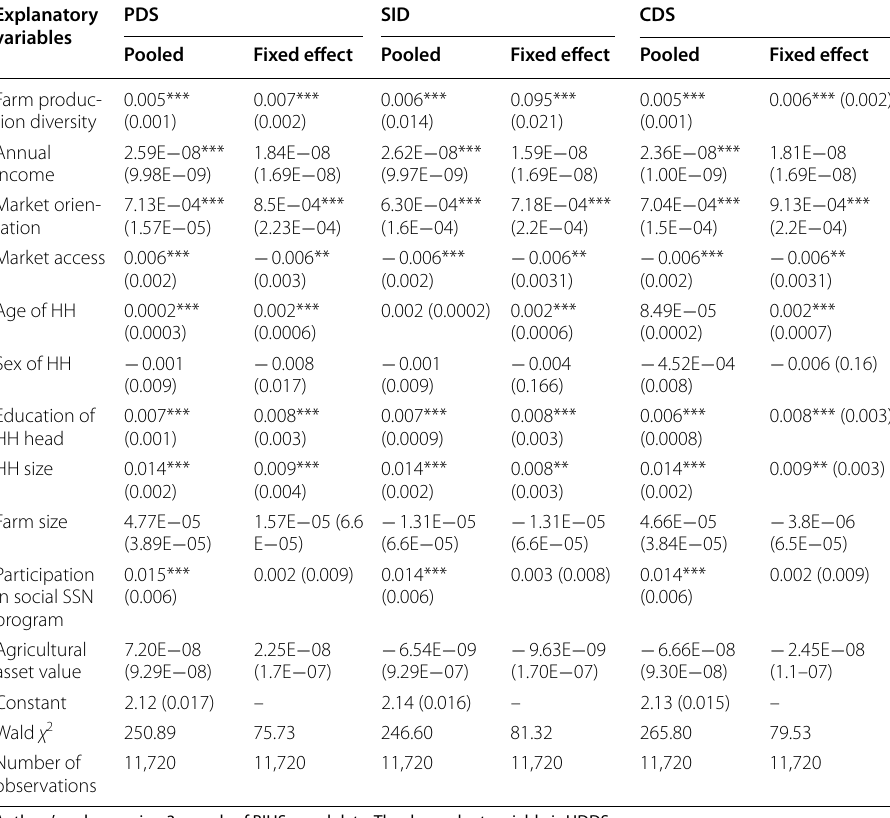
Authors’ analyses using 3 rounds of BIHS panel data. The dependent variable is HDDS ***, and ** indicate significance at the 1% and 5%, levels, respectively; figures in the parentheses are standard